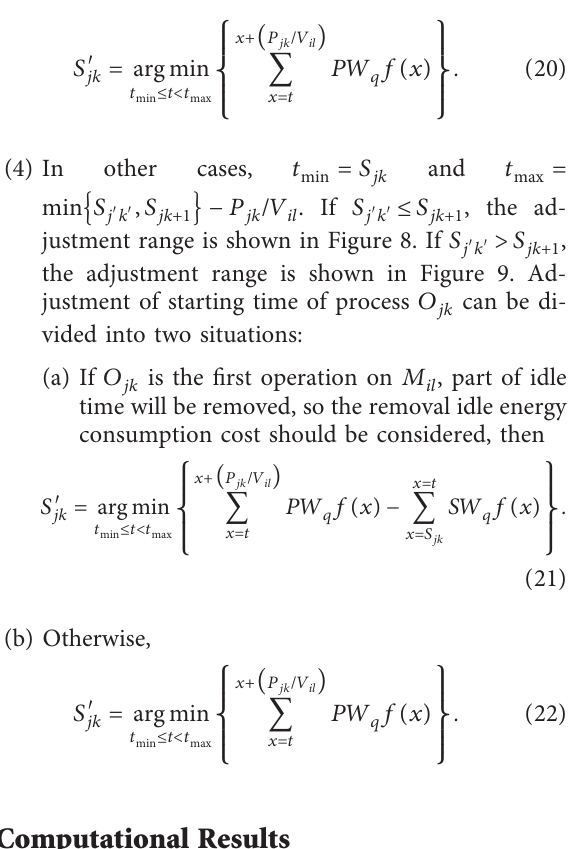
Figure 7: Adjustment diagram when O on machine M il and k ≠ N j .